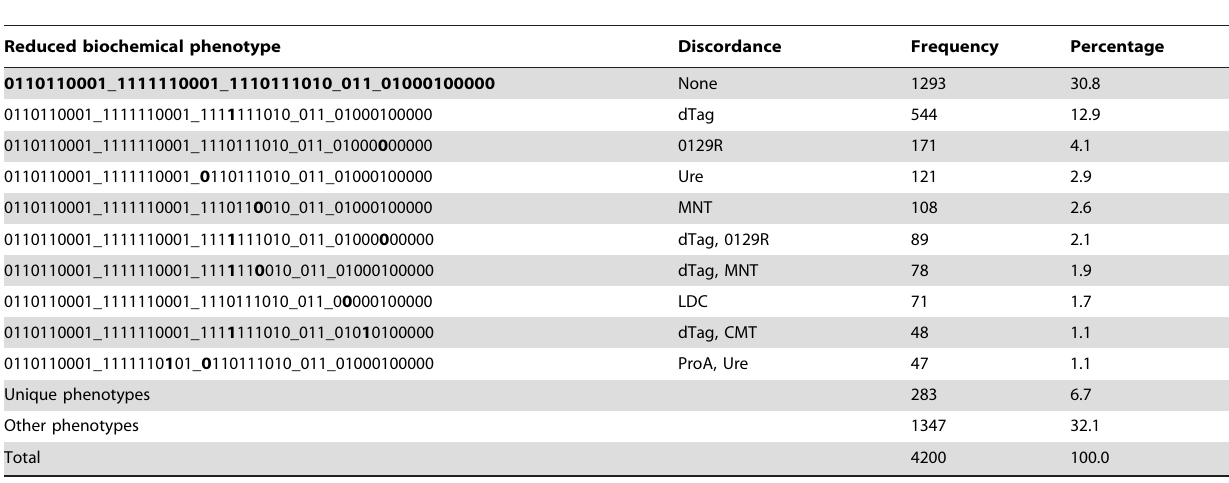
Table 3. Frequency of bionumbers of Klebsiella pneumoniae isolated from specimens collected January 2009–December 2011, considering the biochemical phenotype without 4 biochemical tests (GGT, TyrA, SUCT and